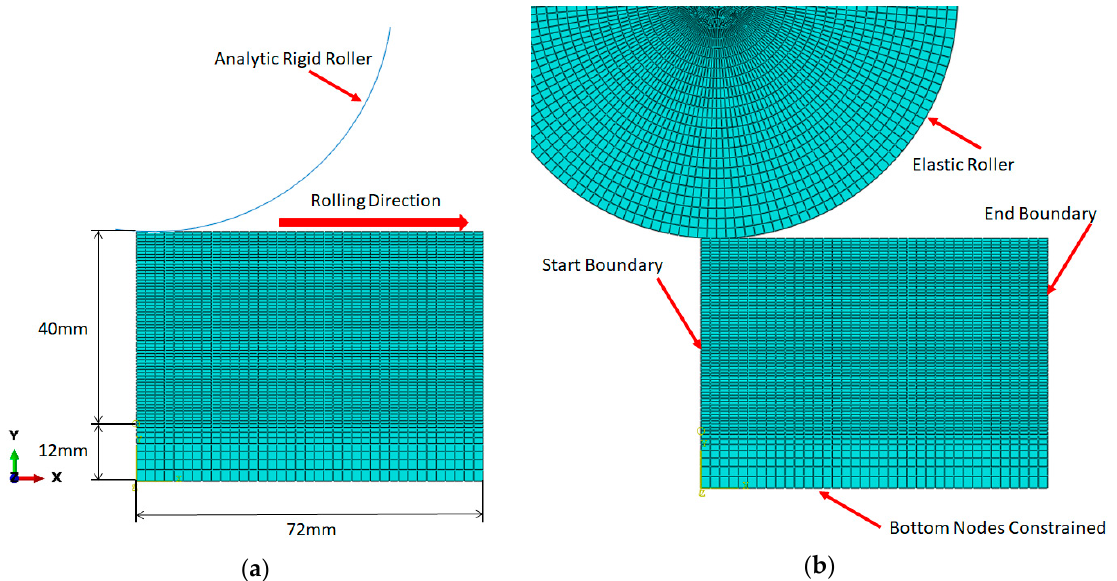
Figure 4. 2D short transient displacement-controlled model: ( a ) with analytic rigid roller; ( b ) with elastic roller.